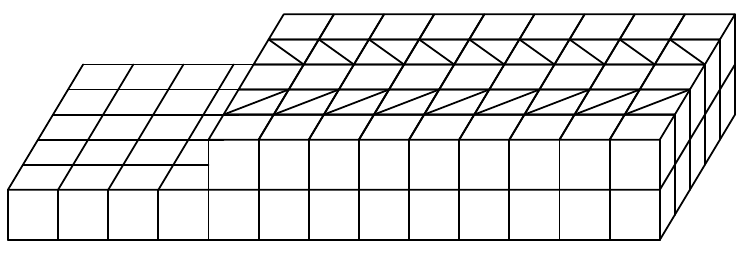
Fig. 11: Layer L and layer of unit